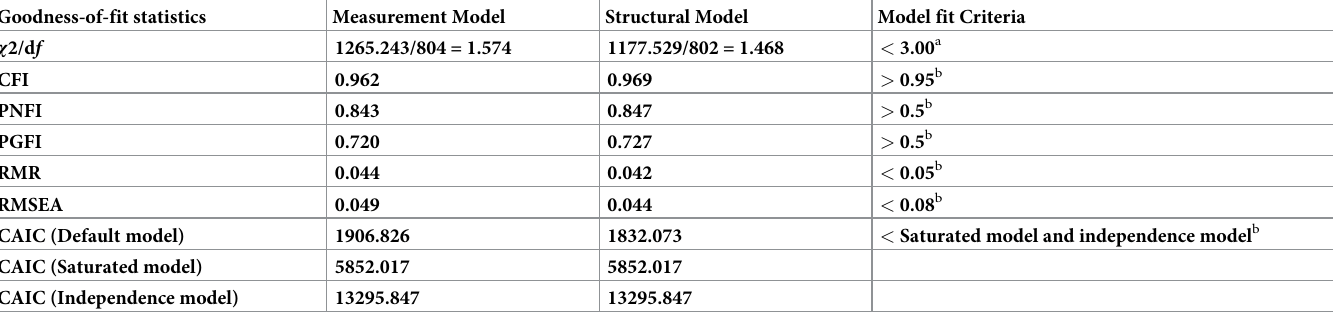
Table 5. Global model fit of the measurement model and structural model.